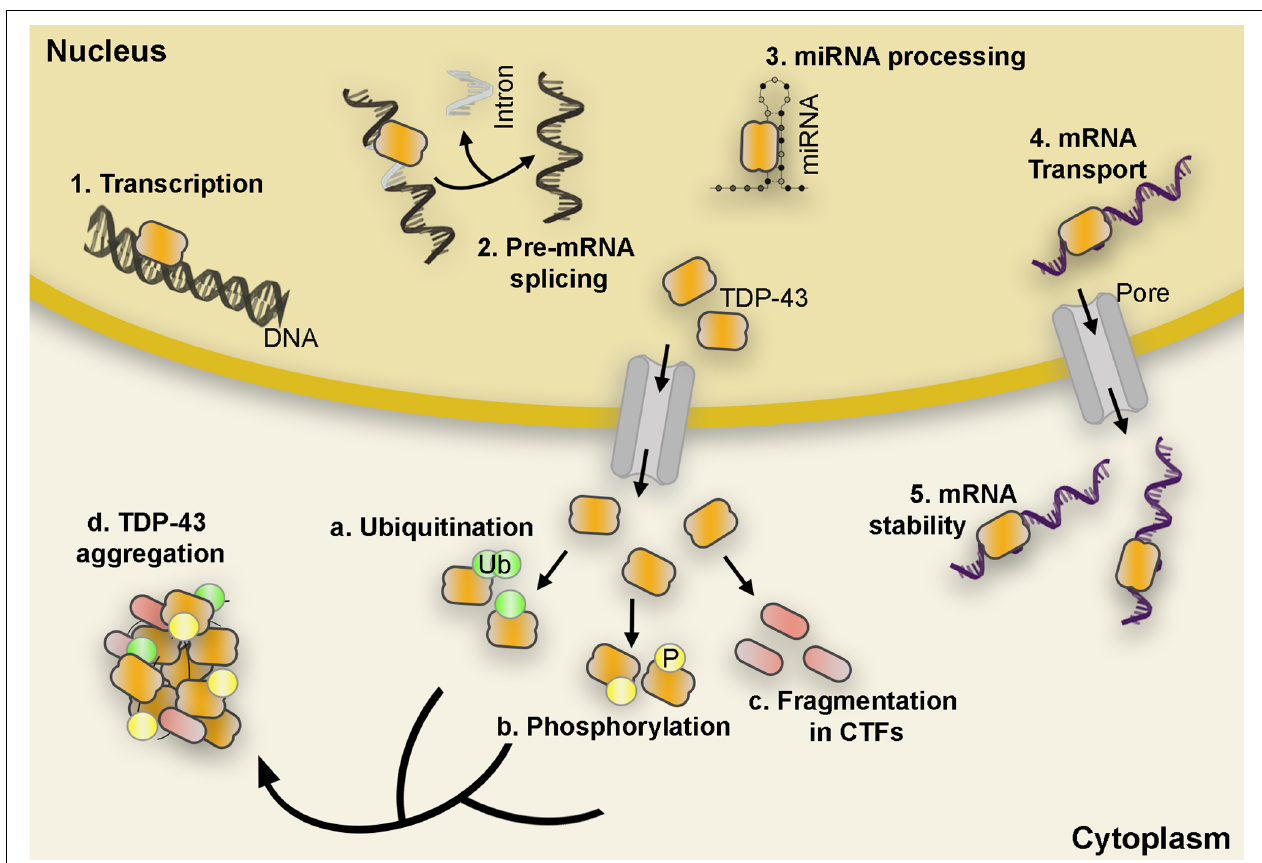
FIGURE 1 | TDP-43 functional roles and post-translational modifications. TDP-43 carries out a variety of functions such as initiation of transcription, pre-mRNA splicing, miRNA processing, mRNA transport, and mRNA stability (1–5) . However, in pathological conditions, TDP-43 is depleted from the nucleus and accumulates in the cytoplasm in hyperphosphorylated, ubiquitinated, and cleaved (CTFs) forms found in the abnormal protein aggregates characteristic of ALS and FTLD proteinopathies (a–d) . Abbreviations: mRNA, messenger RNA; miRNA, microRNA; CTF, C-terminal fragments; ALS, amyotrophic lateral sclerosis; FTLD, Frontotemporal lobar degeneration; Ub, Ubiquitin; P,